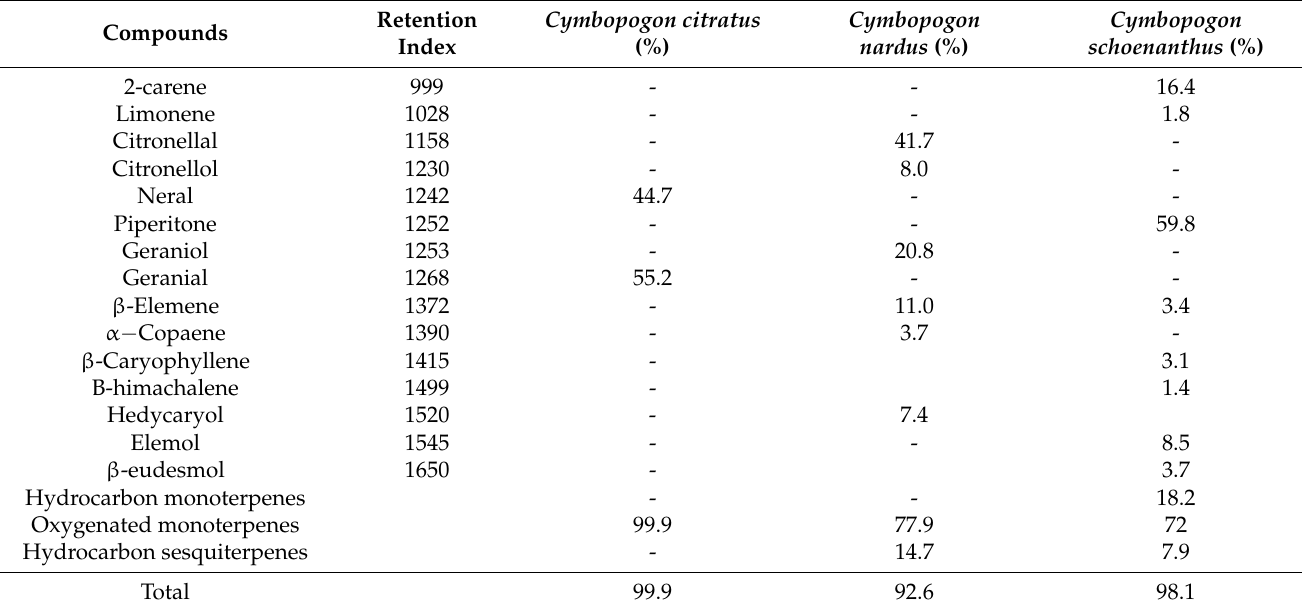
Table 2. Chemical composition of analyzed essential oil samples.